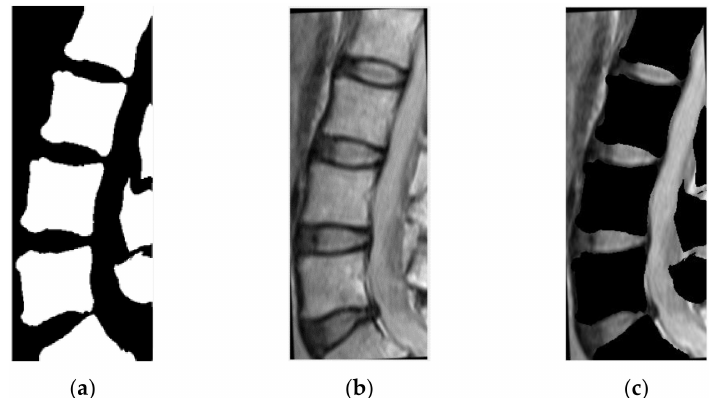
Figure 5. ( a ) The result of CT segmentation, ( b ) registered MRI image, ( c ) the result of masking between the two previous images.